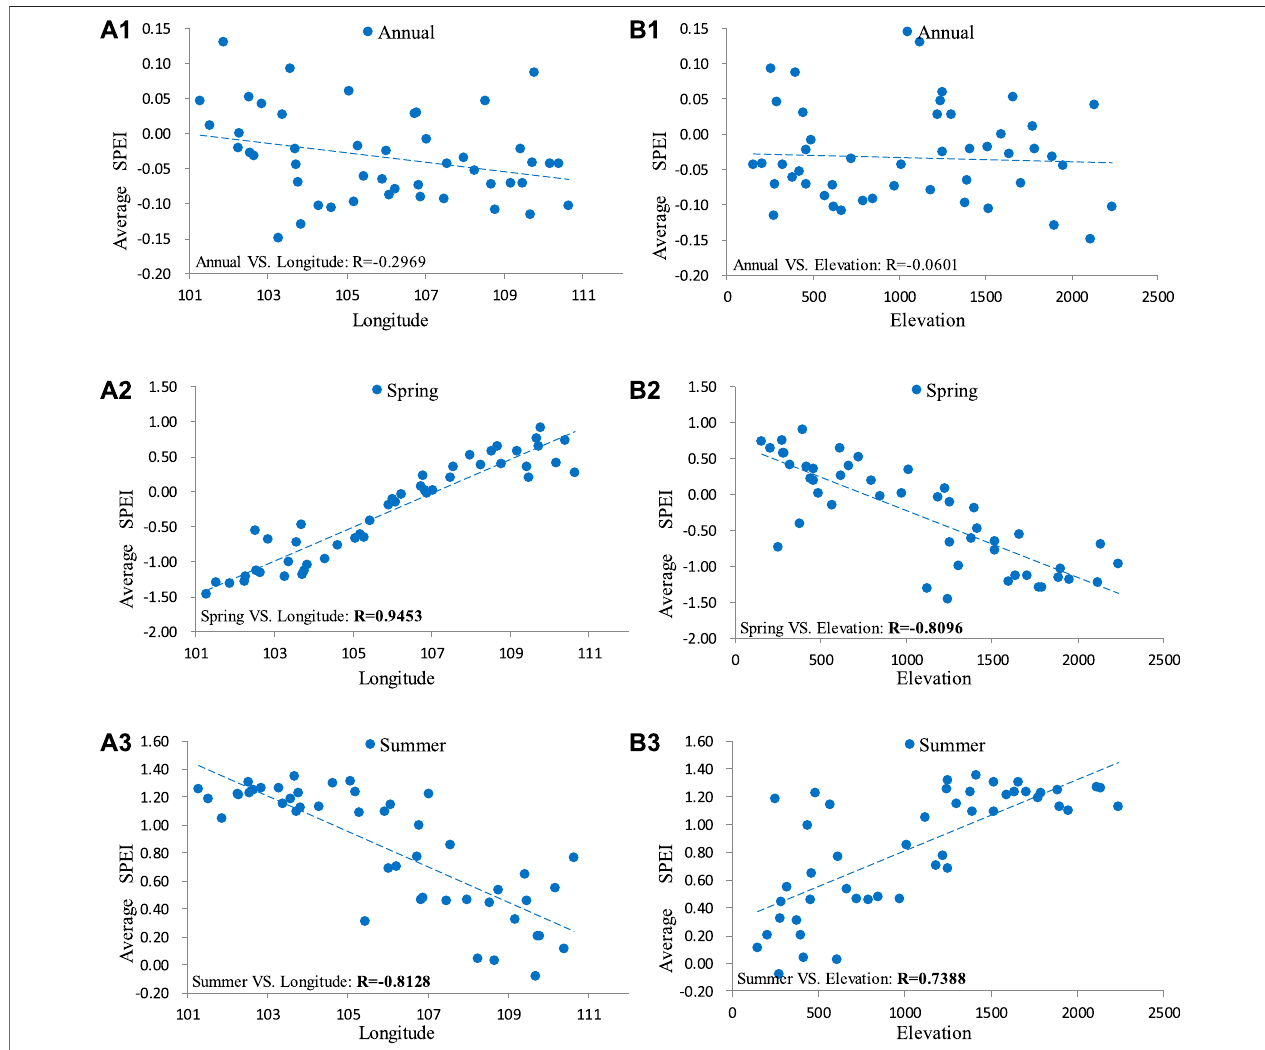
FIGURE 4 | Correlations between the annual and seasonal averages of the SPEI and longitude and elevation. (A1 – A7) represents the correlation between the average SPEI of annual, spring, summer, autumn, winter, rainy season, dry season and longitude; (B1 – B7) represents the correlation between the average SPEI of annual,spring, summer, autumn, winter, rainy season, dry season and elevation. R represents the correlation coef fi cient, and the bold fonts indicate thatthe con fi dence level is α (cid:1) 0.001.